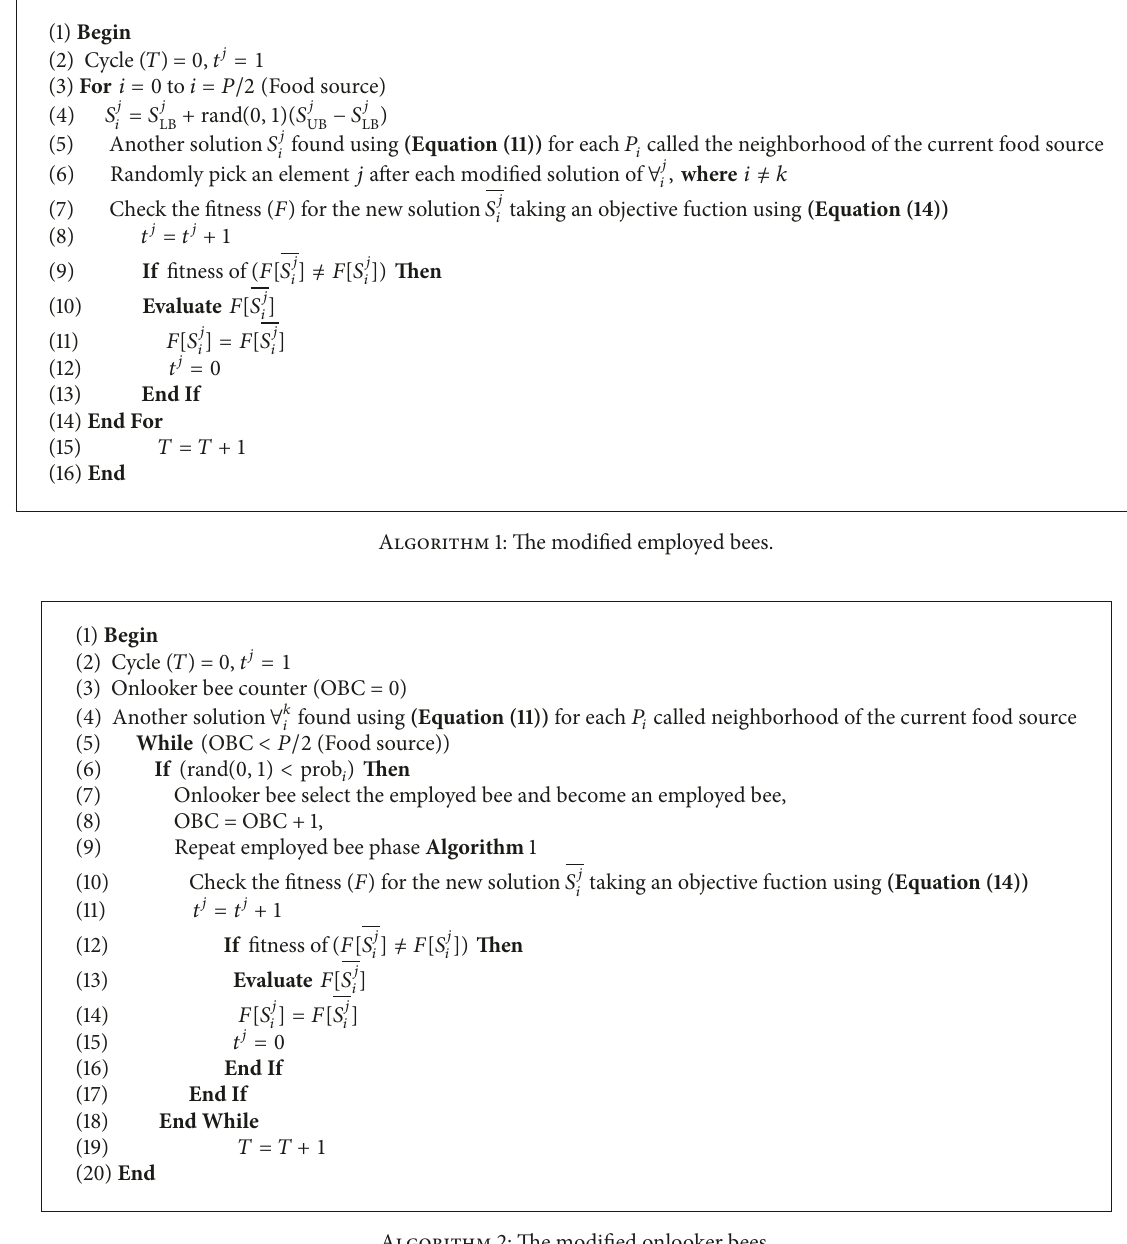
Algorithm 2: The modified onlooker